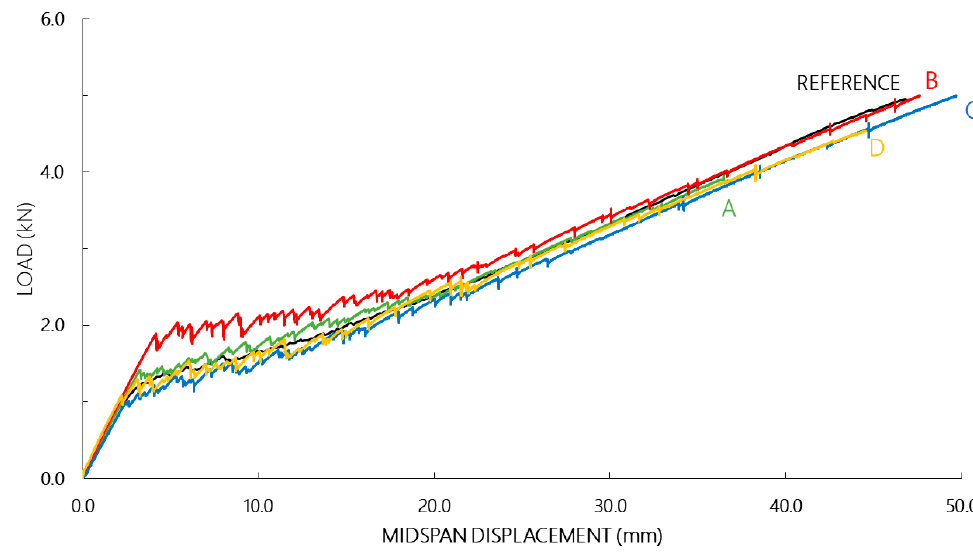
Figure 16. Evolution of the crack width of some representative cracks formed during cyclic loading of sandwich beams.